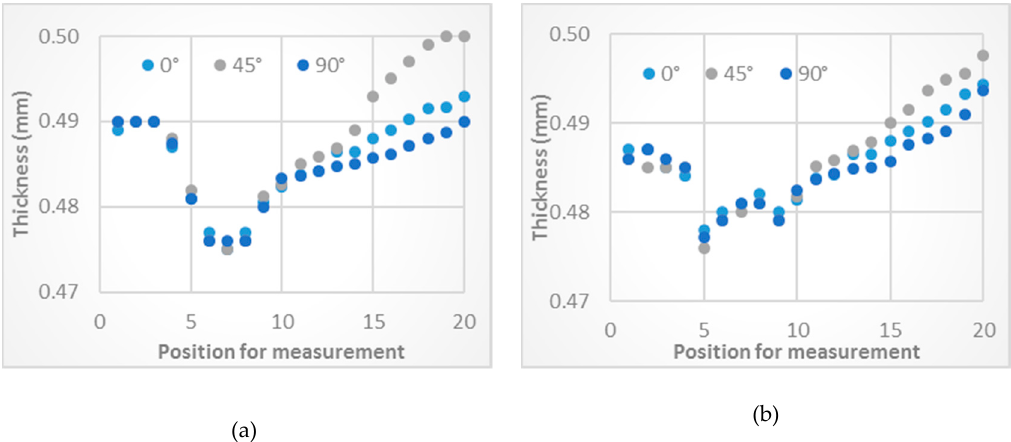
Figure 12. Comparison of cup wall thickness between conventional and MDR die applications obtained by FEM simulation (DR: 2.25; initial blank diameter: 90 mm). ( a ) Conventional die (Radius 3.5 mm); ( b ) Multi draw radius die type I (Radius 3.5–7 mm).